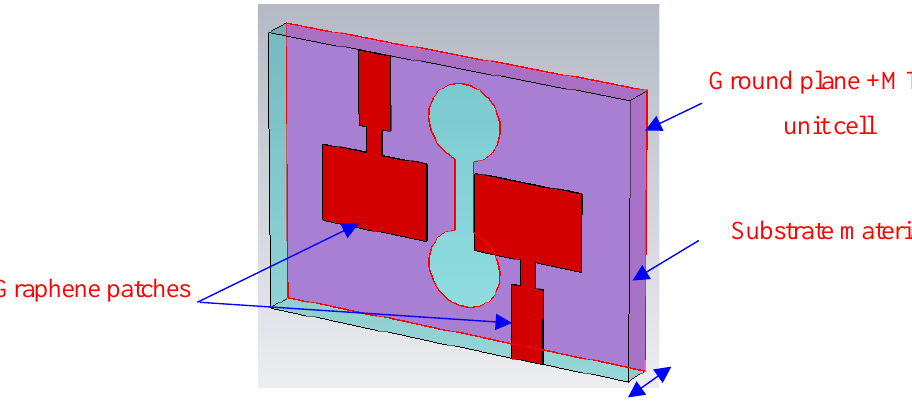
Figure 14. Extracted ( a )permittivity and ( b ) permeability of Dumbbell-structure MTM unit cell.